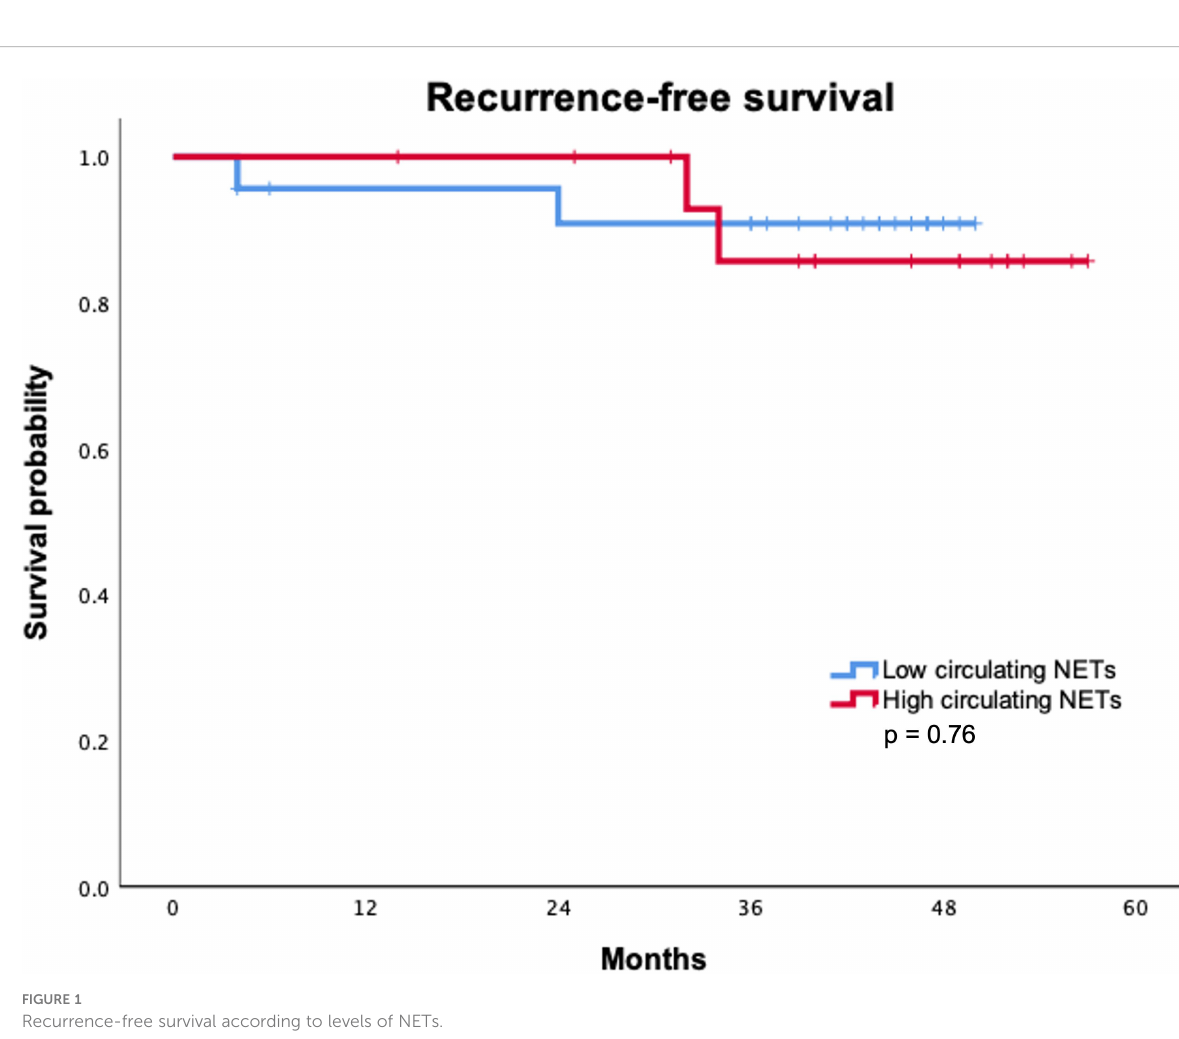
FIGURE 1 Recurrence-free survival according to levels of